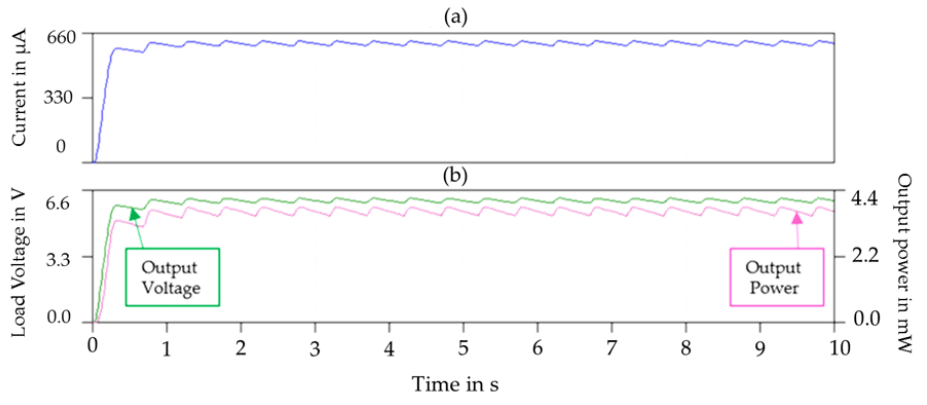
Figure 8. ( a ) Simulated Load current at R = 10 k Ω , ( b ) Simulated output voltage and output power of the proposed SP-PSSHI